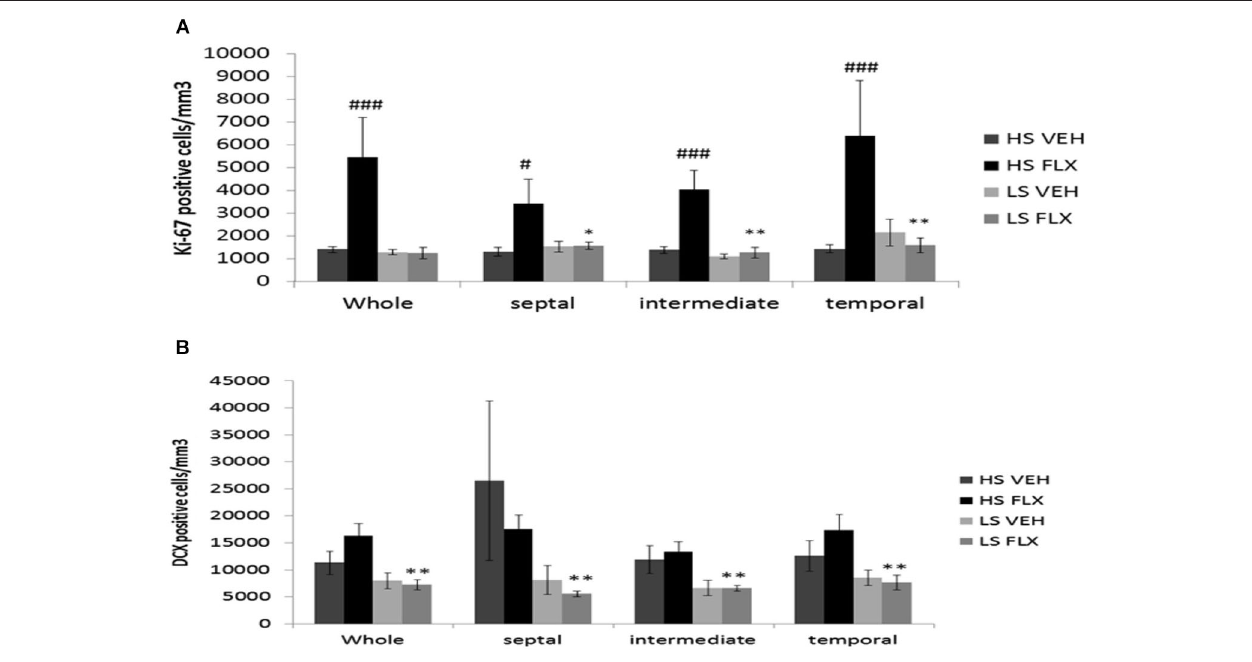
hippocampus: HS VEH ( n = 7), HS FLX ( n = 6), LS VEH ( n = 7), LS FLX ( n = 5)). (B) Density of immature neurons using doublecortin (DCX) labeling in the GCL (whole, temporal and intermediate parts: HS VEH ( n = 5), HS FLX ( n = 6), LS VEH ( n = 6), LS FLX ( n = 4); septal parts: HS VEH ( n = 5), HS FLX ( n = 5), LS VEH ( n = 6), LS FLX ( n = 4)). HS VEH vs. HS FLX: # p < 0.05, ### p < 0.001; HS FLX vs. LS FLX: * p < 0.05, ** p <